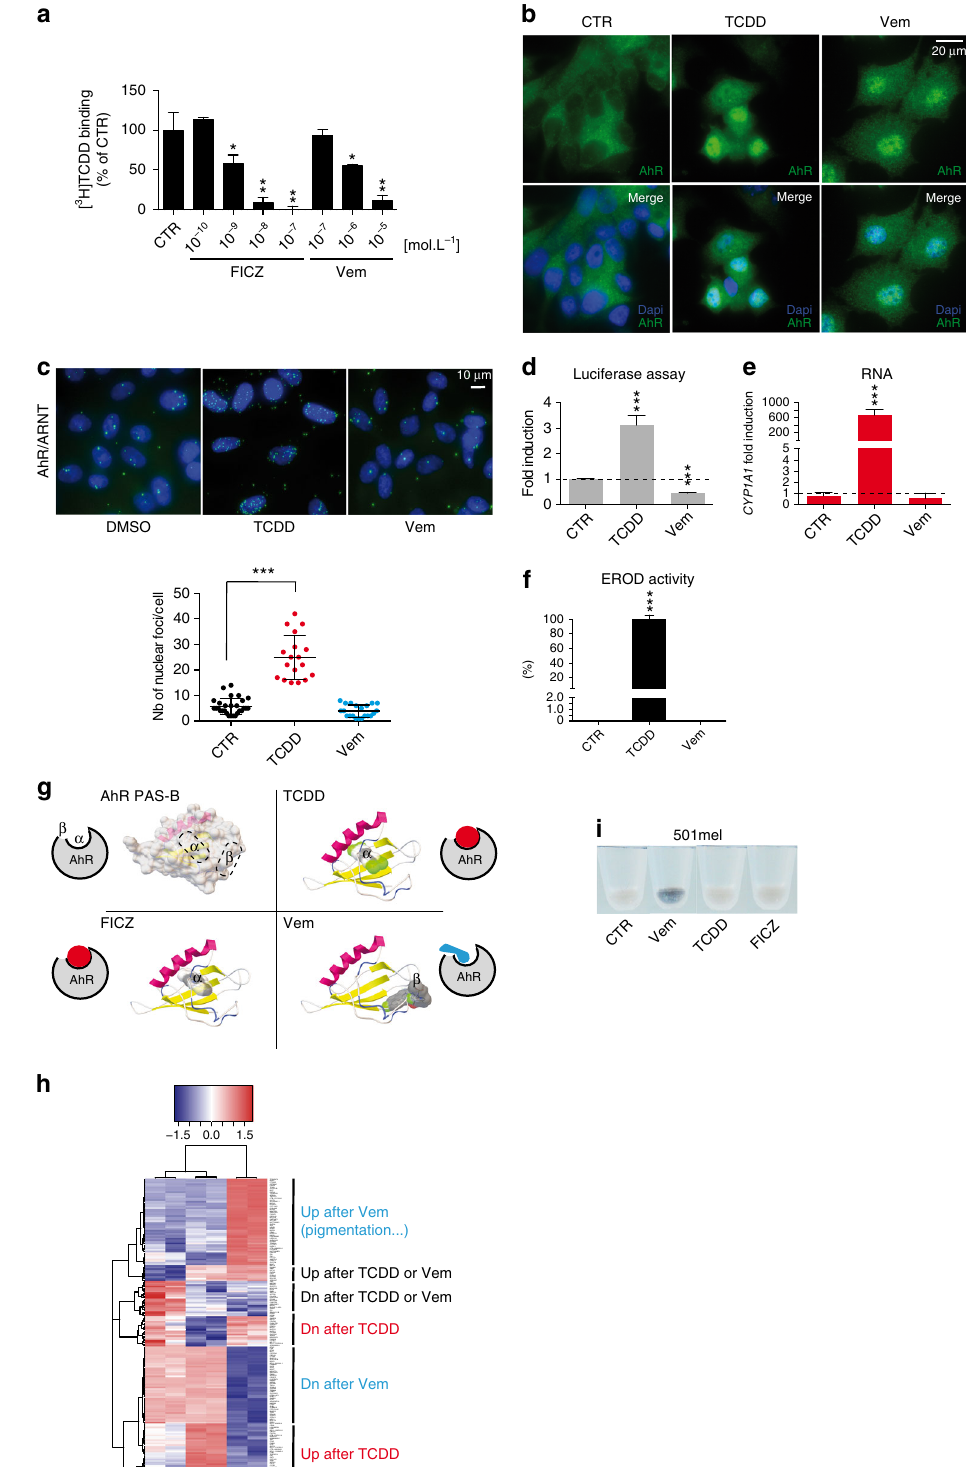
(Fig. 2b) 15,29 . In accordance with the recent classi fi cation of melanoma cells based on their differentiation states (melanocytic, M; transitory, T; neural crest-like, N; and undifferentiated cells, U), we con fi rmed that BRAFi-resistant cells are mostly dediffer- entiated 10 . Moreover, the resistance-signature signi fi cantly